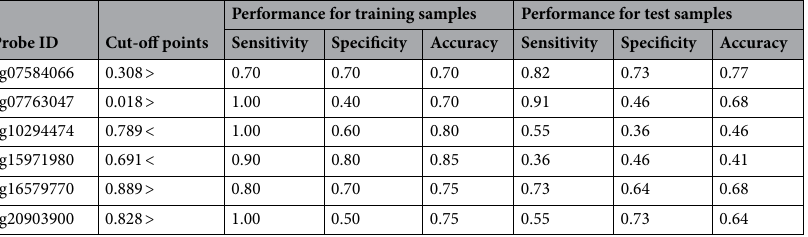
Table 3. Sensitivity, specificity, and accuracy in the independent second set (Group 2) for discrimination between AOD and HC. The optimal cut-off points of Group 1b (training samples) were determined by maximizing the Youden index. Sensitivity, specificity, and discrimination accuracy for Group 2 (independent test samples) were calculated. AOD, adult-onset depression; HC, healthy controls.